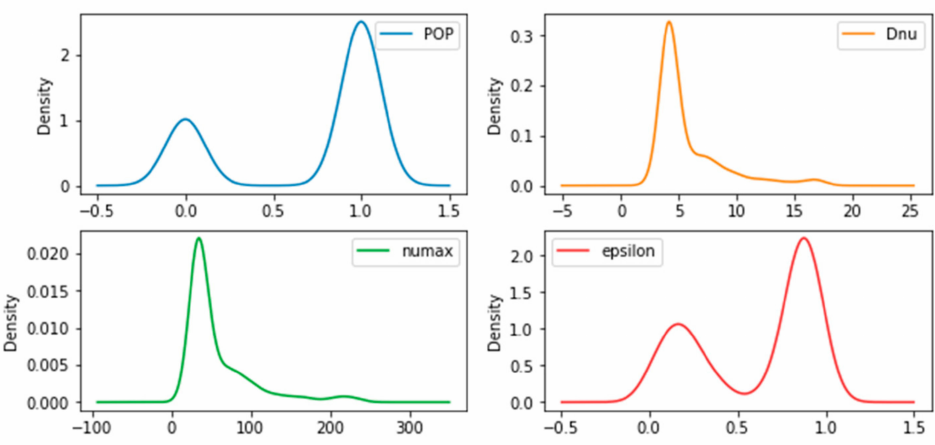
Figure 4. The density graphs analysis of asteroseismology dataset features in time